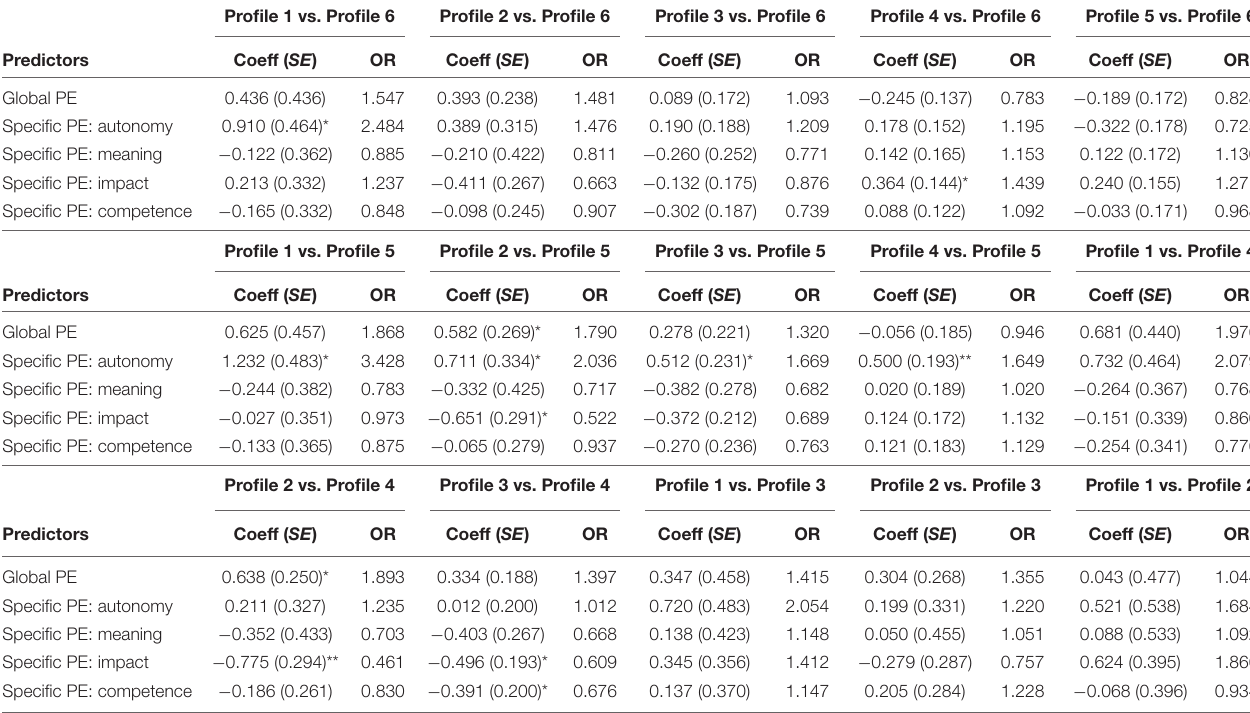
TABLE 2 | Results from the multinomial logistic and multiple regressions predicting profile membership.